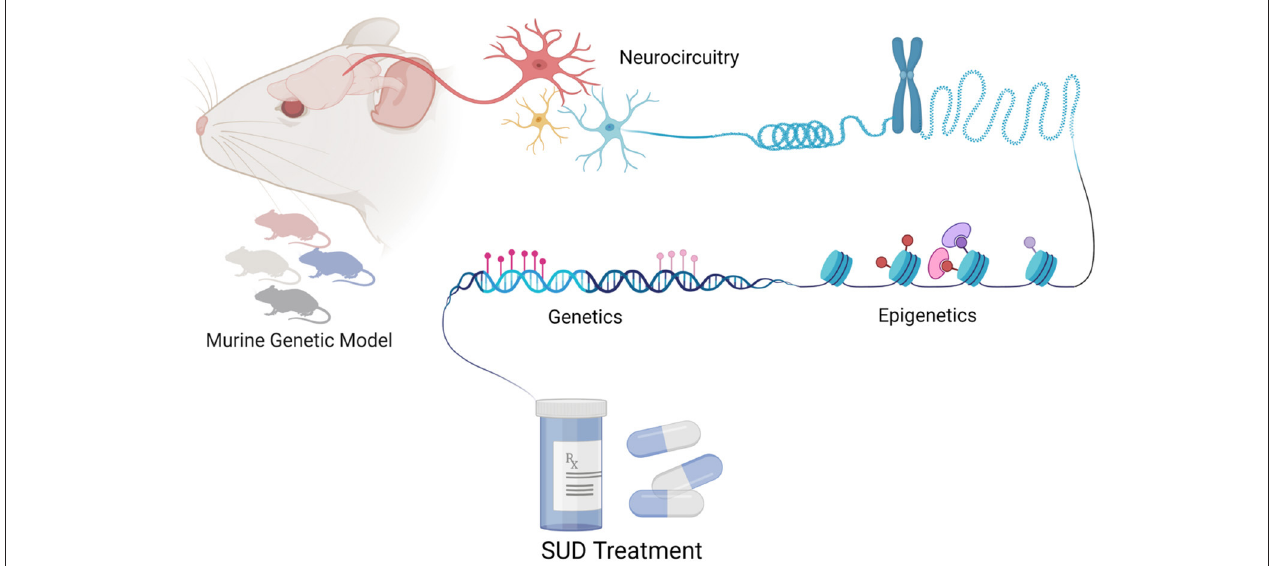
FIGURE 2 | Image depicting how a mouse genetic model of a response related to a SUD can be analyzed to identify the genetic factors, epigenetic changes and the alterations in neurocircuits caused by a DOA. This diagram was created using BioRender.com software.